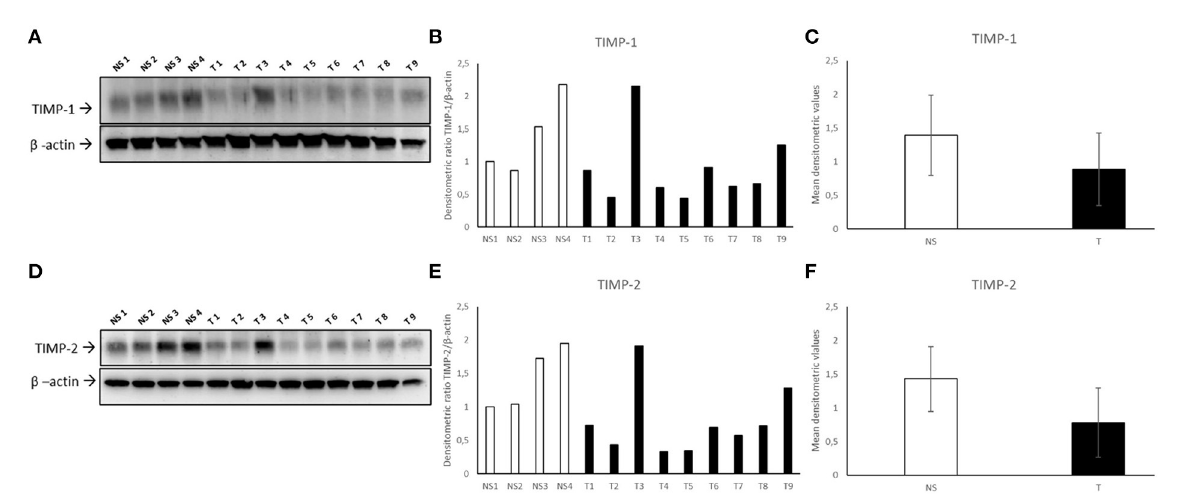
FIGURE9 Western blotting analysis of TIMP-1/-2 in bovine normal skin (NS) and fibropapillomas (T). Western blotting and densitometric measurements of TIMP-1/-2 in NS1-NS4 and T1-T9 samples (A–F) . Representative gels showing a decreased amount of TIMP-1/-2 in tumor compared with normal skin samples are shown (A,D) . The blots were stripped and reprobed with anti- β -actin antibody to confirm comparable loading of proteins in each lane and allow normalization. (B,E) Individual densitometric values of TIMP-1/-2 for each sample expressed as densitometric ratio with β -actin. (C,F) Mean densitometric values + /- standard deviations for TIMP-1/-2 in NS vs. T groups.